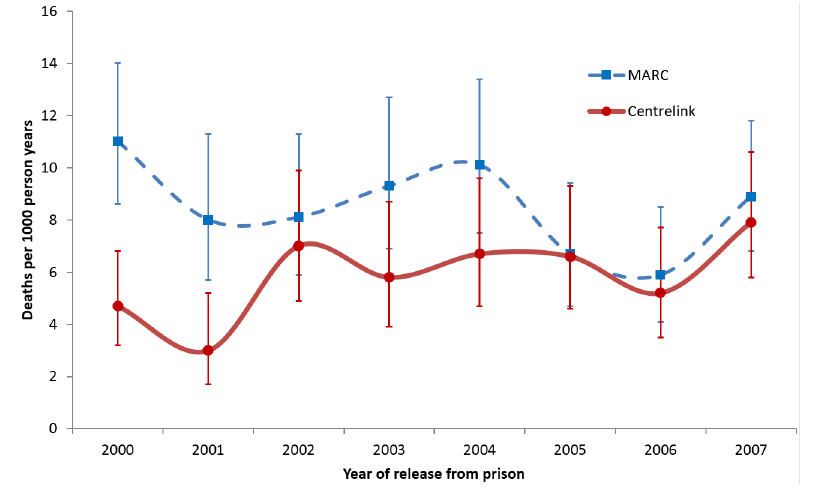
Fig 1. Estimated CMR within 365 days of release, based on MARC and Centrelink data.